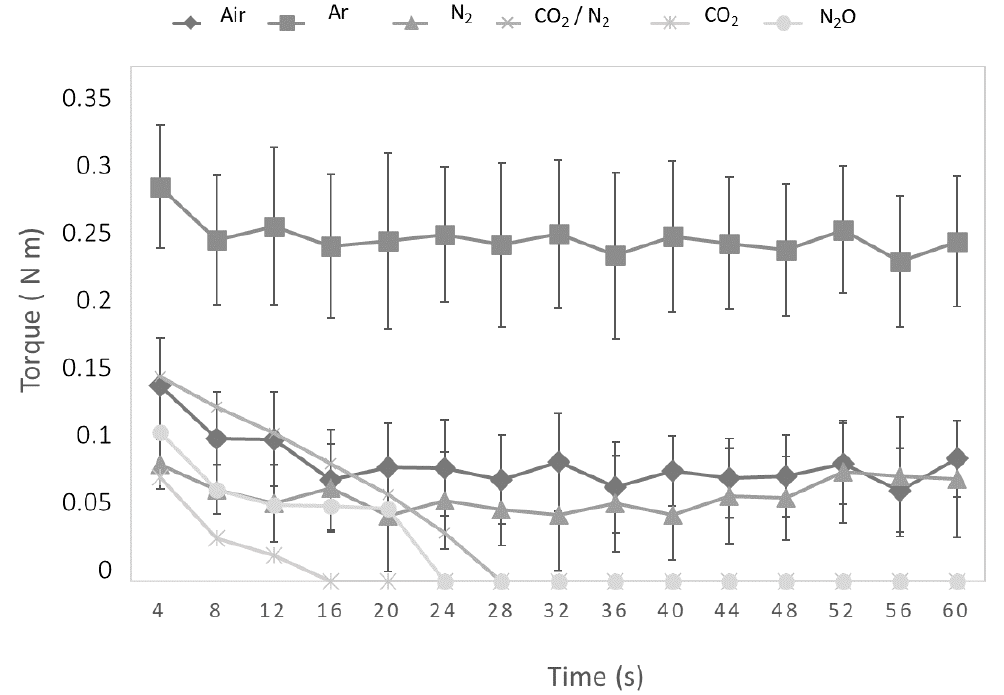
Figure 1. Torque measurements (N m) as a function of time(s) for the six gases.